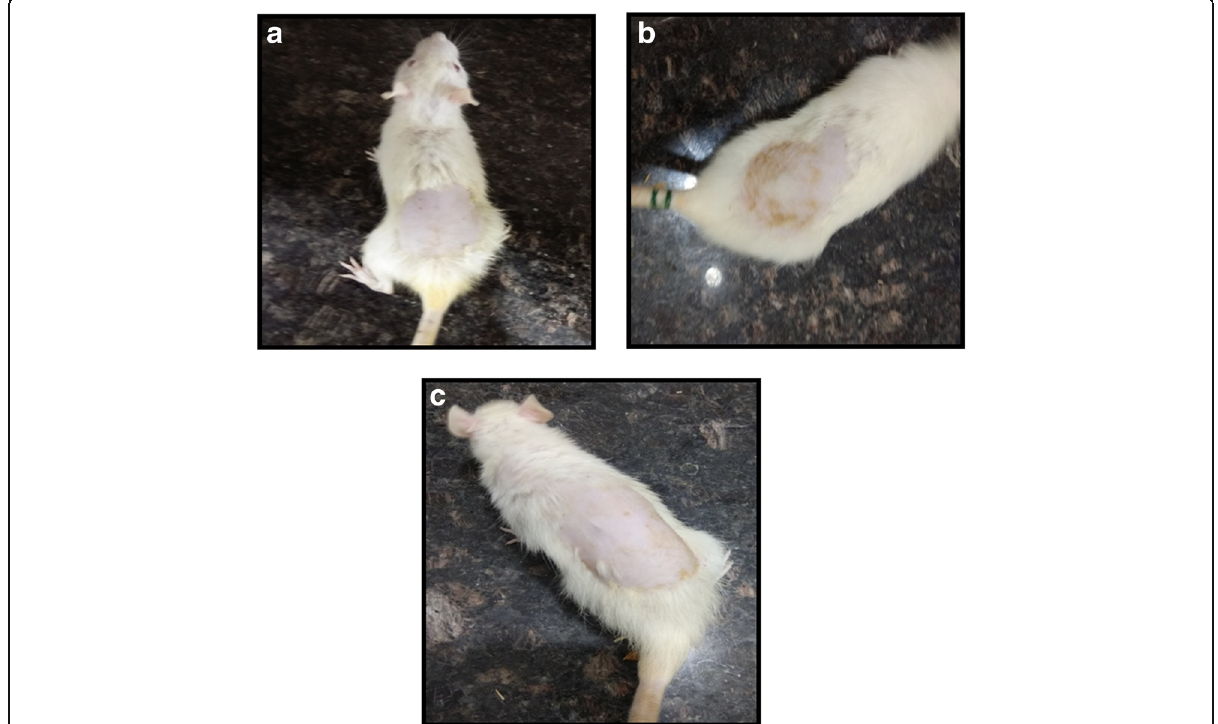
Fig. 3 Photographic images of the study a : Naive Control, b : Psoriasis Induced, c : Test